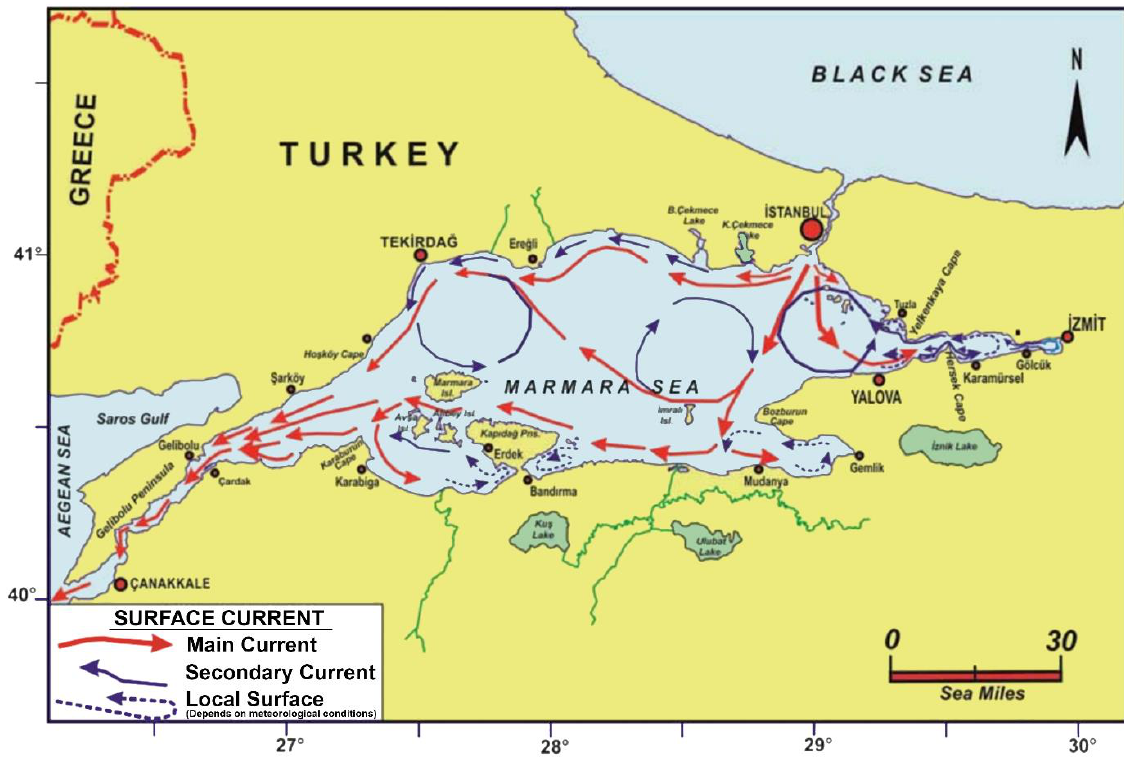
Figure 8. Wind speed and direction information for Izmit Bay between 17 May 2021 and 31 May Figure 7. Surface currents in Sea of Marmara ([50]). Figure 7. Surface currents in Sea of Marmara 2021 (source: www.meteoblue.com, accessed on 15 June 2022).